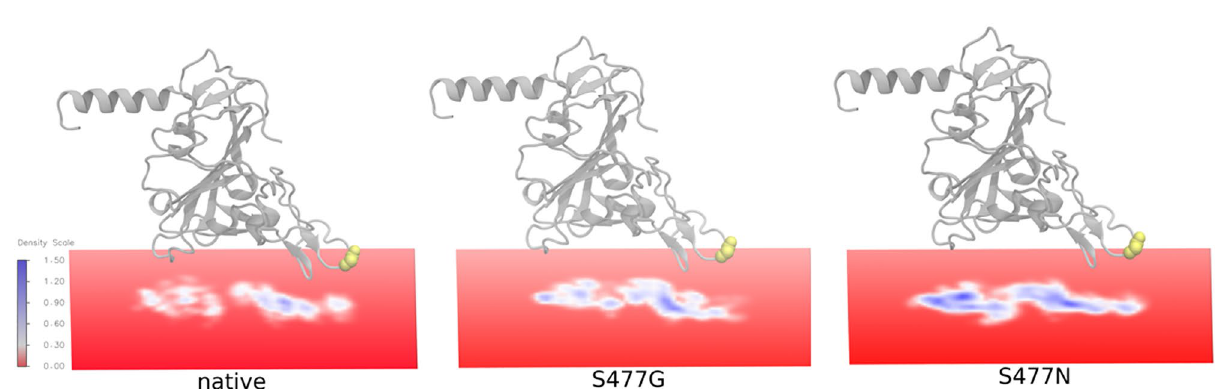
Figure 3. Volumetric map analysis of 100 ns trajectory showing the hACE2 residues within 5 Å of RBD. Native RBD and the variants S477G and S477N are shown as grey cartoon representations with residue 477 highlighted in yellow. The Volumetric map was created by using the VMD 53 Volmap toolkit that generated a map of the weighted atomic density of every ACE2 atom within 5 Å of RBD at each gridpoint. This is done by replacing each atom in the selection with a normalized gaussian distribution of width (standard deviation) equal to its atomic